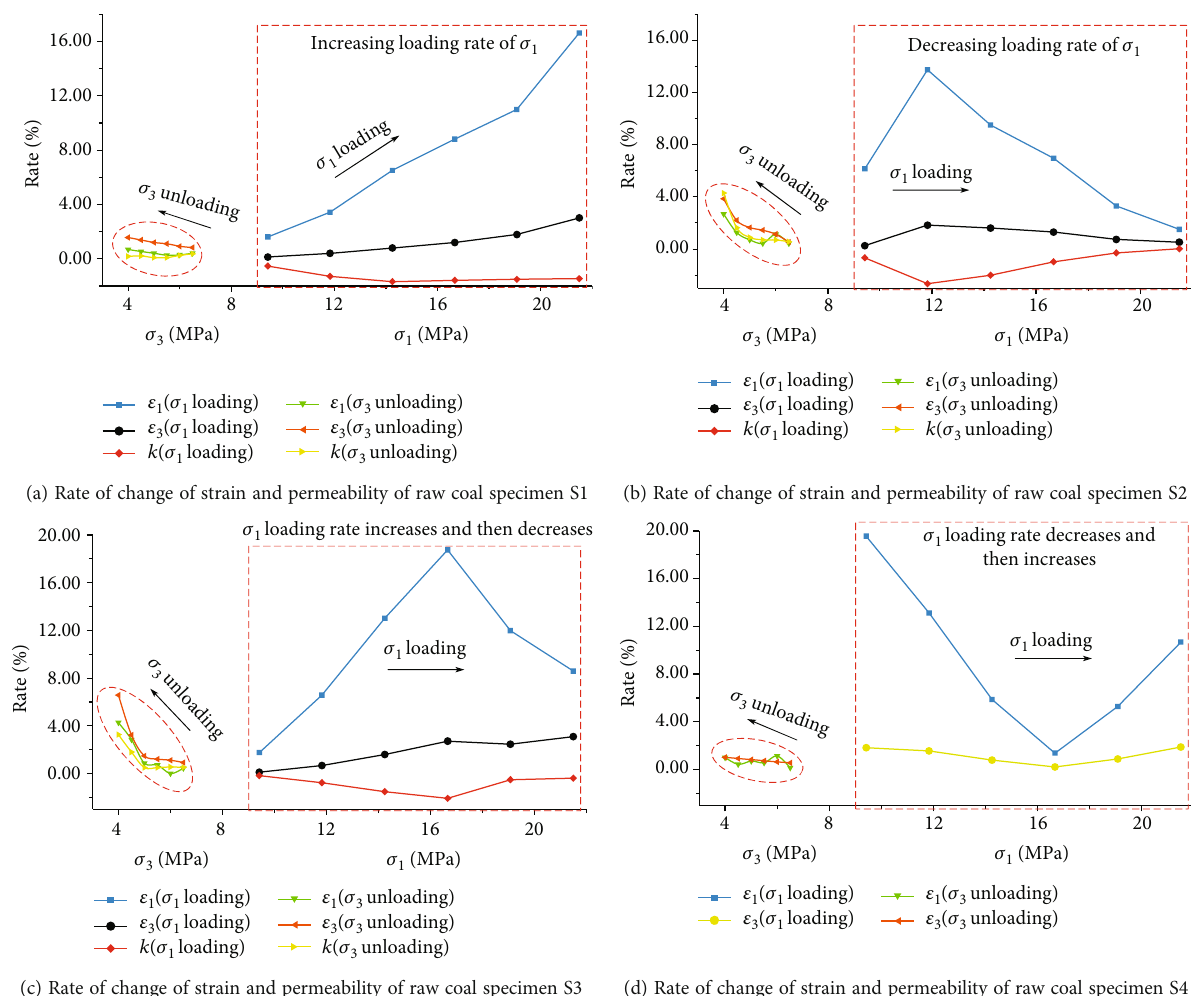
Figure 6: Rate of change of strain and permeability of raw coal under variable axial pressure loading rate